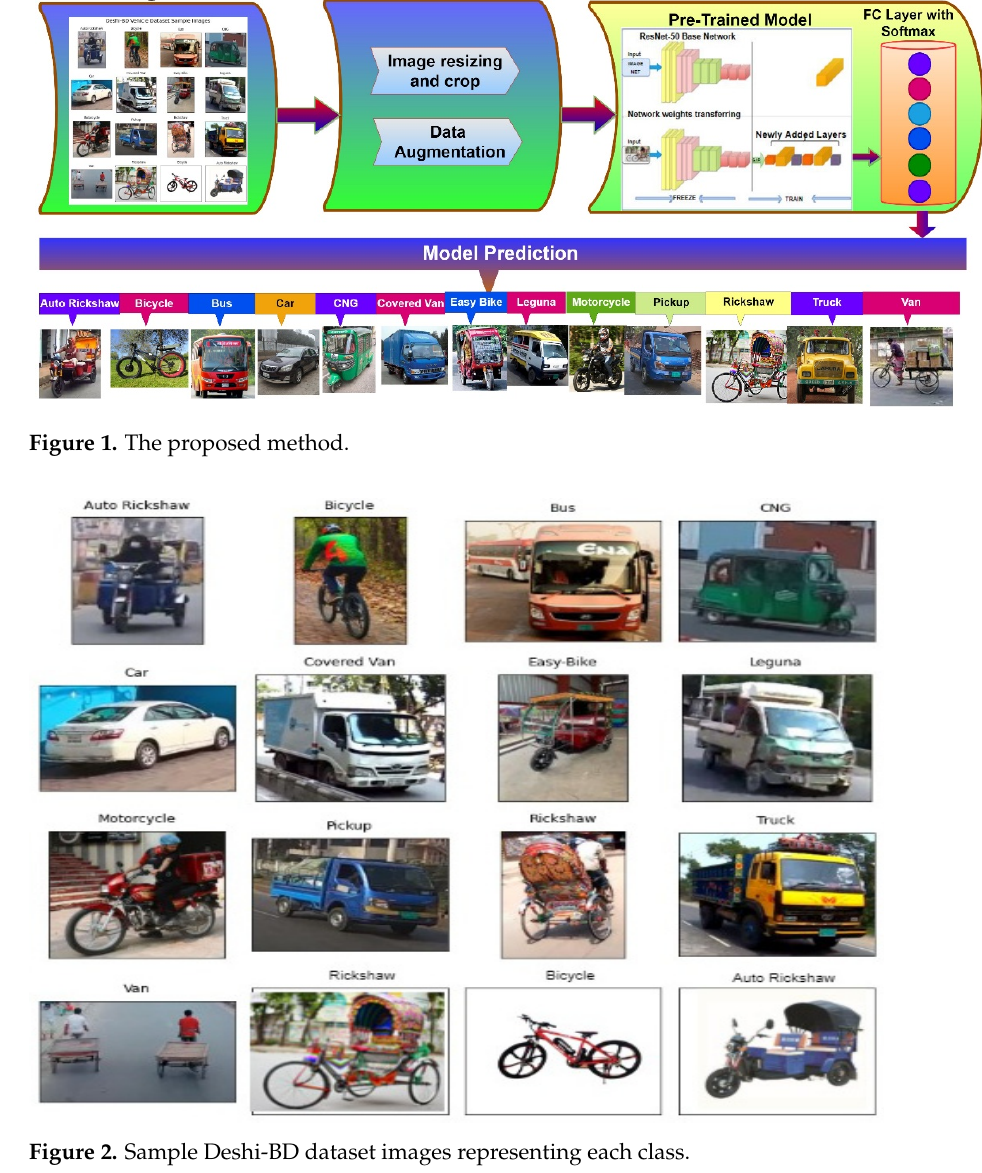
Figure 1. The proposed method.